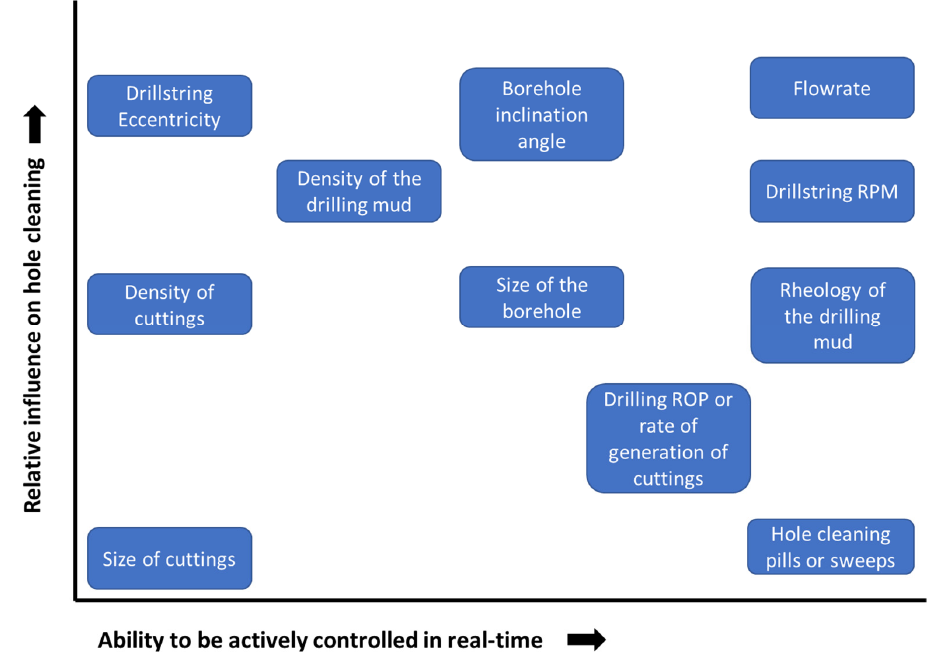
Figure 8. Variables contributing to the hole cleaning performance in a deviated hole (modified from [35]).